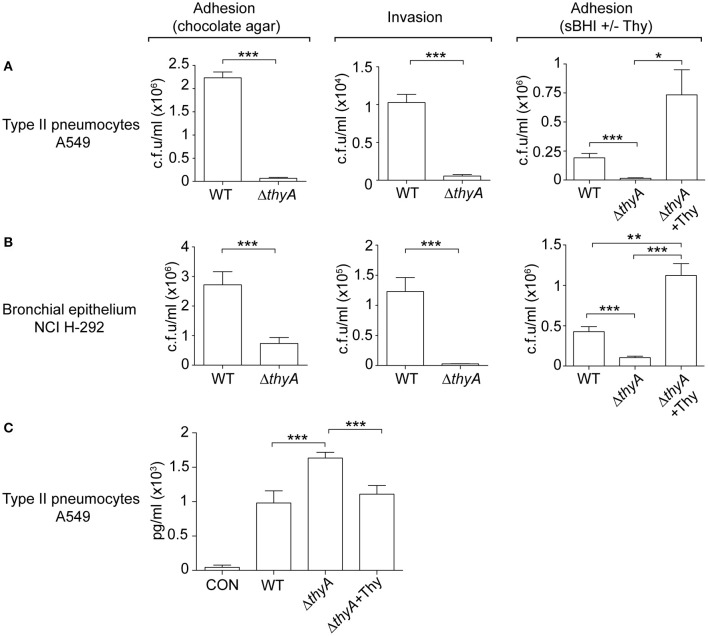
The thyA gene inactivation modulates H. influenzae interplay with cultured human airway epithelia. A549 type II pneumocytes (A) and NCI H-292 bronchial epithelial cells (B) were used to quantify adhesion and invasion by NTHi375 WT and ΔthyA strains. For adhesion, infecting inocula were prepared by using bacteria previously grown on chocolate agar following previously established methods (Morey et al., 2011; left). Alternatively, bacteria previously grown on sBHI, in the absence or presence of thymidine (sBHI±Thy), were used (right). NTHi375ΔthyA showed significantly lower adhesion to A549 (chocolate agar, p < 0.005; sBHI, p < 0.005) and NCI H-292 (chocolate agar, p < 0.005; sBHI, p < 0.005) cells than the WT strain, which was restored by mutant pre-growth in sBHI with thymidine 300 μg/ml (A549, p < 0.05; NCI H-292, p < 0.005). NTHi375ΔthyA showed significantly lower entry into A549 (p < 0.005) and NCI H-292 (p < 0.005) cells than the WT strain. (C) IL-8 release was higher in cells infected by NTHi375ΔthyA than by the WT strain (p < 0.005); NTHi375ΔthyA growth on chocolate+Thy reduced IL-8 secretion to WT levels (p < 0.005). *p < 0.05, **p < 0.005, ***p < 0.005.